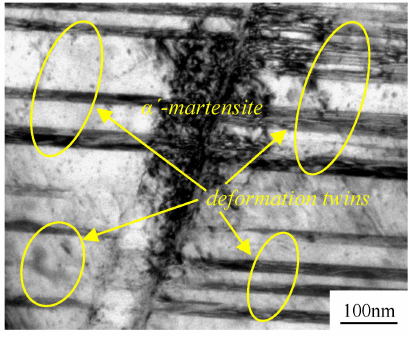
Figure 7. Martensite formed at the interaction position of deformation